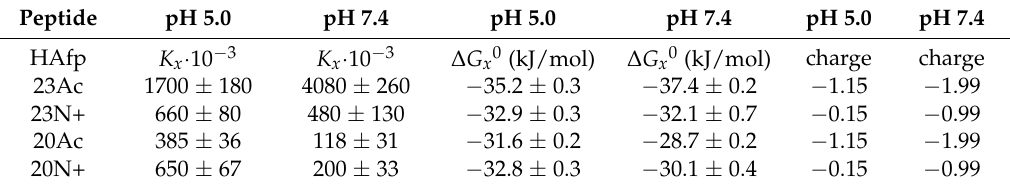
Figure 4. The number of hydrogen bonds with water ( top ) and phosphate groups ( bottom ) formed by subsequent peptide residues. Note that the peptide structure attached here for illustration does not represent the most typical tight hairpin conformation but rather the boomerang-like one. Table 1. Partition coefficients and Gibbs binding free energies for fusion peptides. Total charges calculated based on pK values according to [13]: G1 N-term: 8.8; E11: 5.31; and D19: 4.35. Detailed data on the position of λ max and spectral widths can be found in the Supplementary Figure